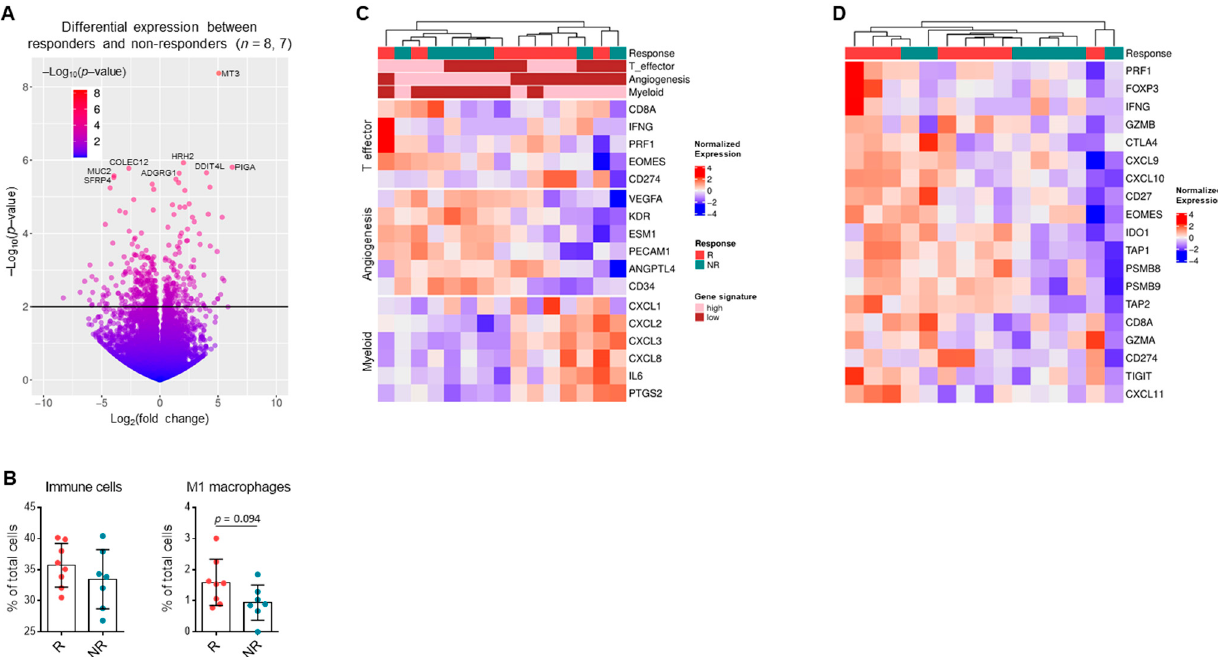
Figure 5. Gene expression patterns in RCC suggest response to single-agent immunotherapy. ( A ) Volcano plot depicting statistical significance against fold-change expression of differentially expressed genes from responders ( n = 8) and non-responders ( n = 7) in biomarker cohort based on RNA-seq data. Top eight differentially expressed genes labeled. ( B ) Percentages of all immune cells and M1 macrophages in bulk tumor samples from responders compared to non-responders based on deconvolution analysis. Data shown are averages ± SD, unpaired Mann–Whitney U-test ( n = 8, 7). ( C ) Heatmap depicting clustering of tumor samples by T effector, angiogenesis, and myeloid signature scores. ( D ) Heatmap depicting clustering of tumor samples by expanded immune and antigen-presenting gene expression panel.